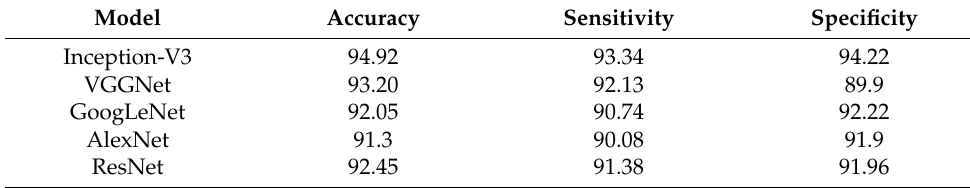
Table 7. Performance of the proposed